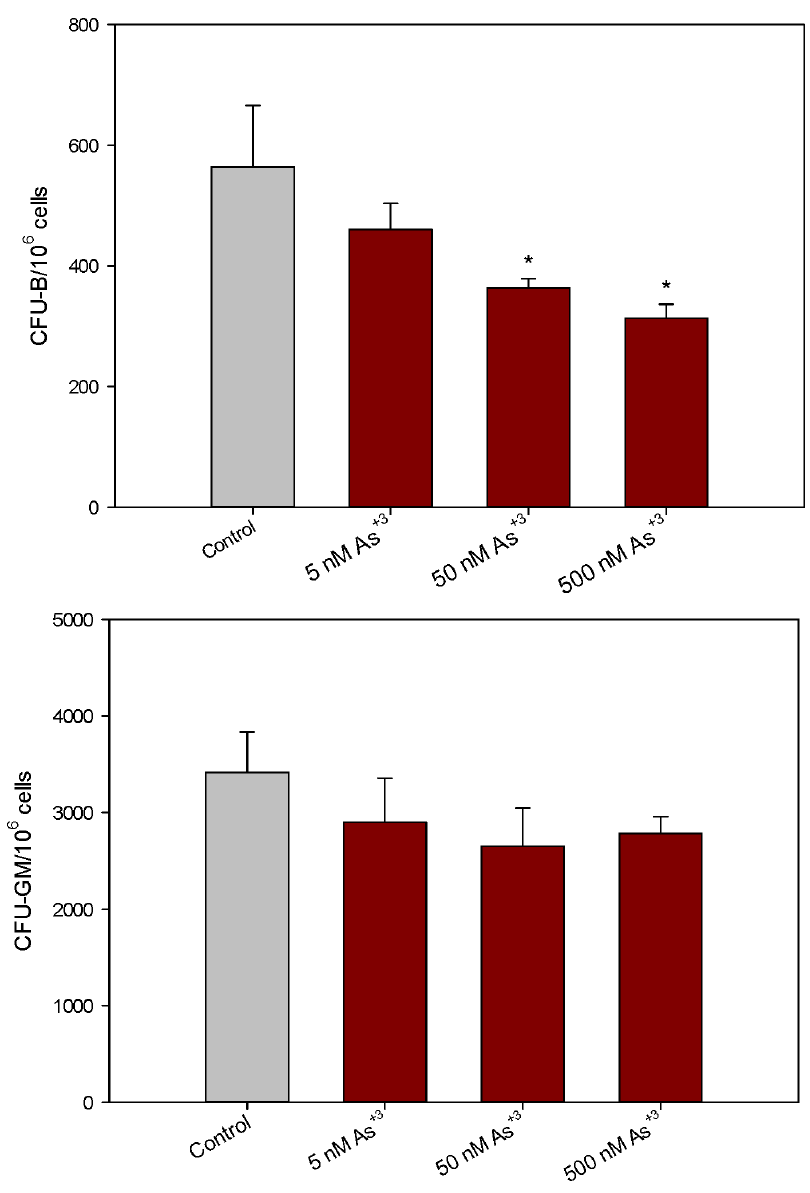
Figure 5. Number of colonies per million cells exposed to As + 3 invitro . Number of CFU-B colonies per million cells 10 days post plating in mouse methylcellulose media (containing As + 3 ) for pre-B cells [Top]. Number of CFU-GM colonies per million cells 14 days post plating in mouse methylcellulose media (containing As + 3 ) for GM cells [Bottom]. * Significantly different compared to control (p , 0.05). Results are Means + SD.